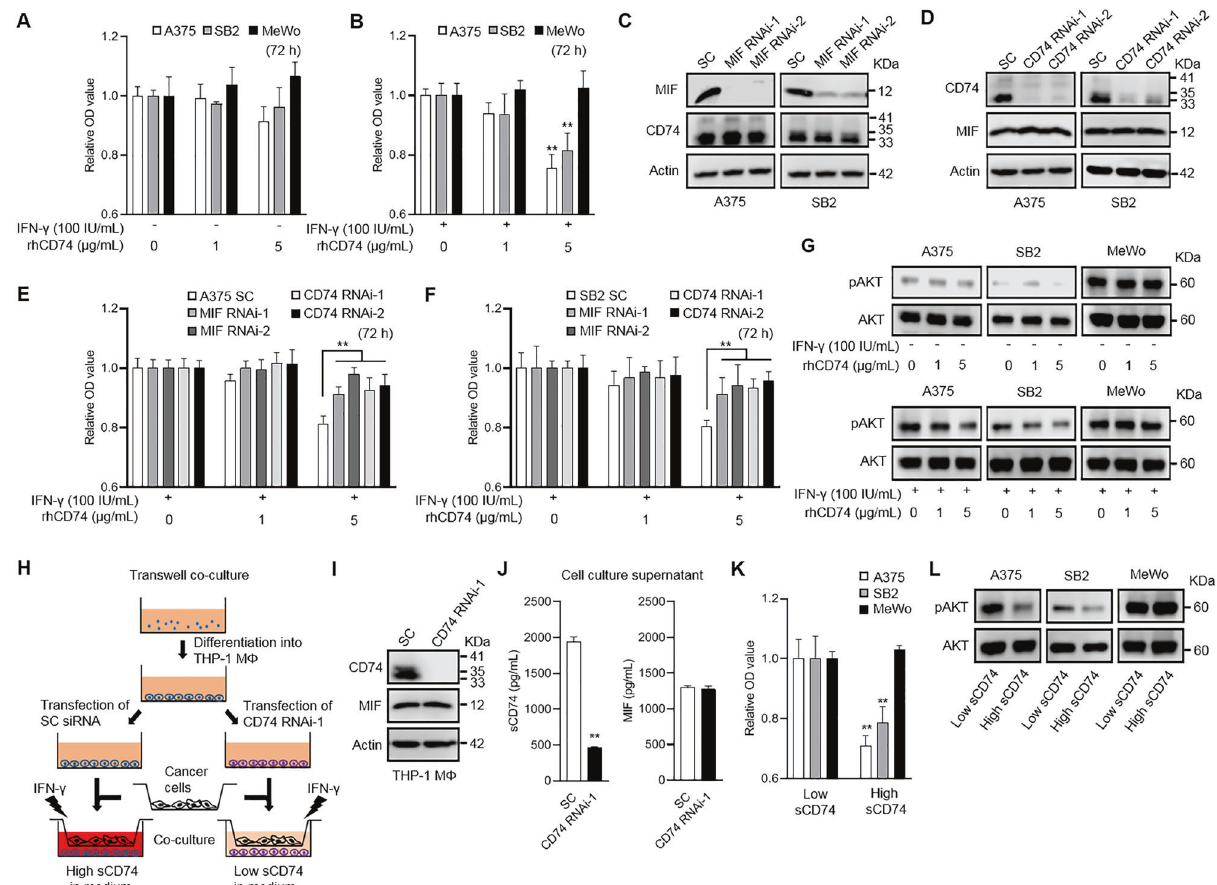
Fig. 4 Impact of sCD74 on melanoma cell growth. A , B Cell-proliferation assay in A375, SB2, and MeWo. Cells were treated with different concentrations of rhCD74 (0, 1, and 5 µg/mL) for 72 h under basal conditions ( A ) or under 100 IU/mL IFN- γ stimulatory conditions ( B ). Results represent the fold change relative to the O.D. value of each cell line treated with 0 µg/mL rhCD74 ( n = 6). C Ef fi cacies of two individual siRNAs in knocking down MIF were analyzed by WB in A375 and SB2. MIF siRNAs did not change CD74 expression. SC siRNA was used as a reference control. D Ef fi cacies of two individual siRNAs in knocking down CD74 were analyzed by WB in A375 and SB2. CD74 siRNAs did not change MIF expression. SC siRNA was used as a reference control. E , F Cell-proliferation assay in A375 ( E ) and SB2 ( F ) transfected with SC siRNA, MIF RNAi-1 and -2, and CD74 RNAi-1 and -2. Cells were treated with different concentrations of rhCD74 (0, 1, and 5 µg/mL) for 72 h under 100 IU/mL IFN- γ stimulatory conditions. Results represent the fold change relative to the O.D. value of each transfected cell treated with 0 µg/mL rhCD74 ( n = 6). Cell-growth inhibitory effect of 5 µg/mL rhCD74 was signi fi cantly diminished in A375 and SB2 transfected with MIF RNAi-1 and -2, and CD74 RNAi-1 and -2, compared with those transfected with SC siRNA. G WB analysis of pAKT in A375, SB2, and MeWo treated with